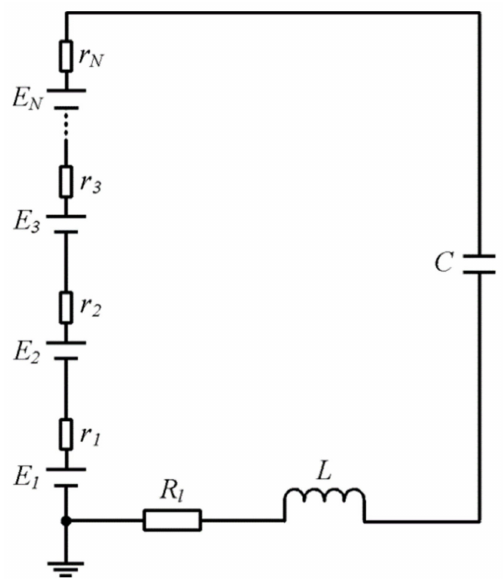
Figure 2. Diagram of the simplified circuit of the battery-pulse capacitor charging